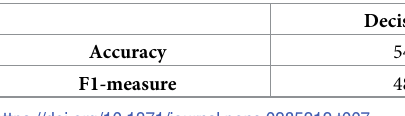
Table 4. Classifier evaluation criteria on the poker